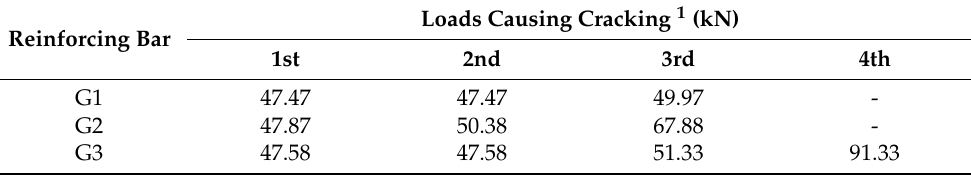
Table 3. Loads causing cracking in the crack formation stage (concrete C2).